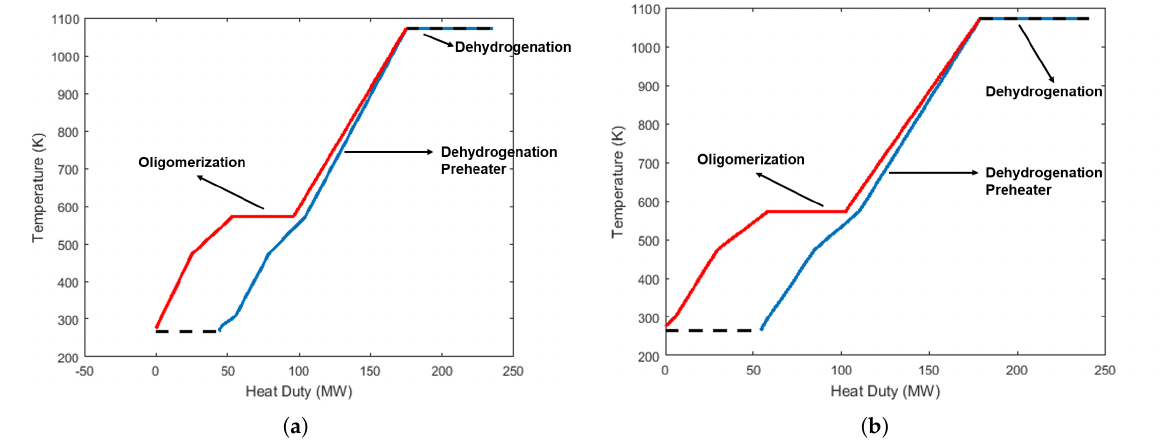
Figure 5. ( a ) Composite curve for Process I. ( b ) Composite curve for Process II.